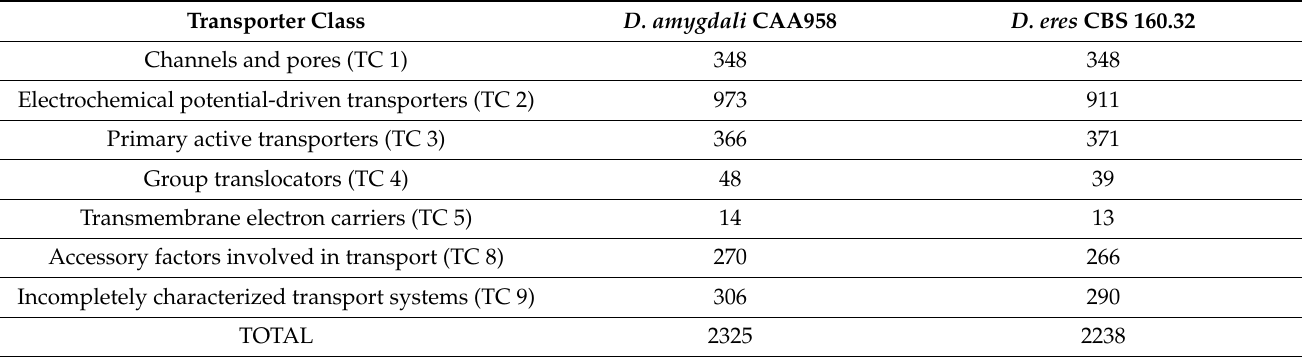
Table 4. Number of genes predicted to code for transporters in the genomes of Diaporthe amygdali CAA958 and Diaporthe eres CBS